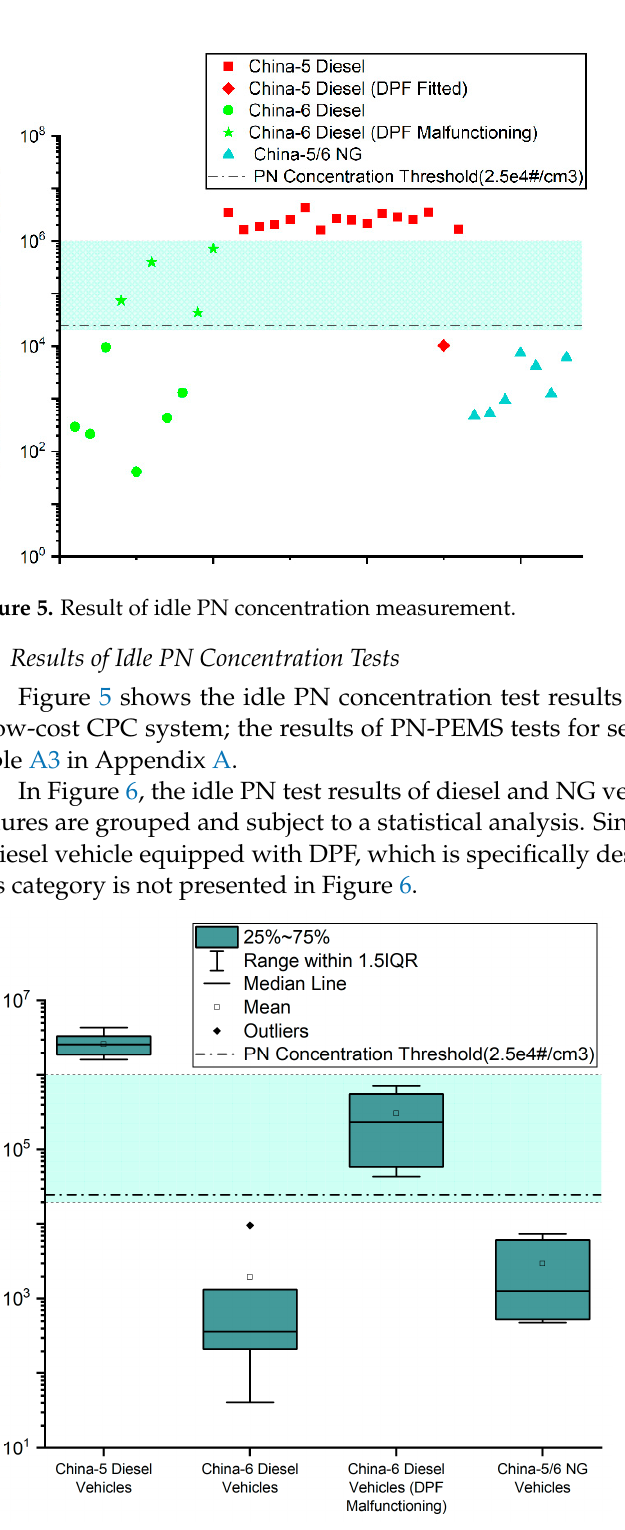
Figure 6. Distribution characteristics of the results of tested vehicles.